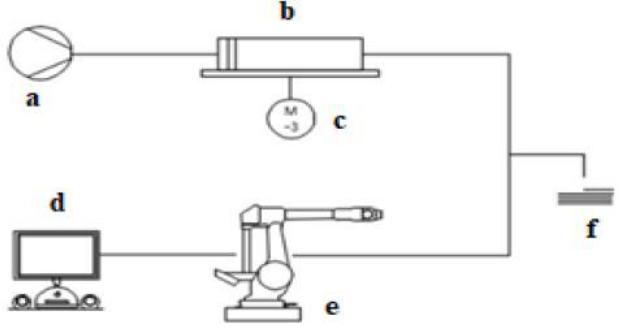
Figure 7. Schematic of the printing system: ( a ) compressor, ( b ) mixing unit, ( c ) vibrating plate, ( d ) software control unit, ( e ) robotic arm + extrusion hose, ( f ) printing platform (reprinted with permission from [44]).